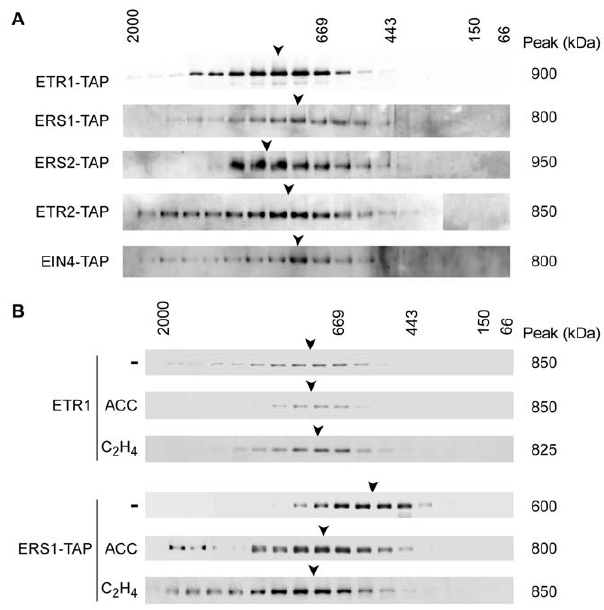
Figure 2. Protein complexes formed by subfamily-1 and subfamily-2 ethylene receptors. (A) Ethylene-receptor protein complexes isolated from plants grown in liquid culture. TAP-tagged versions of the receptors were transgenically expressed in Arabidopsis, solubilized from microsomes by LPC, and analyzed by gel-filtration. TAP-tagged proteins were detected using a rabbit anti-goat IgG antibody coupled to horse-radish peroxidase. (B) Ligand-mediated effects upon the ERS1 and ETR1 ethylene receptor protein complexes. Four-day-old etiolated seedlings from wild-type or ERS1-TAP transgenic plants were treated with the ethylene biosynthesis precursor 50 m M ACC or with 10 m L/L ethylene (C 2 H 4 ). The ACC treatment was for four days while the ethylene treatment was for 6 hr. Differences of 50 kDa or less are not significant.